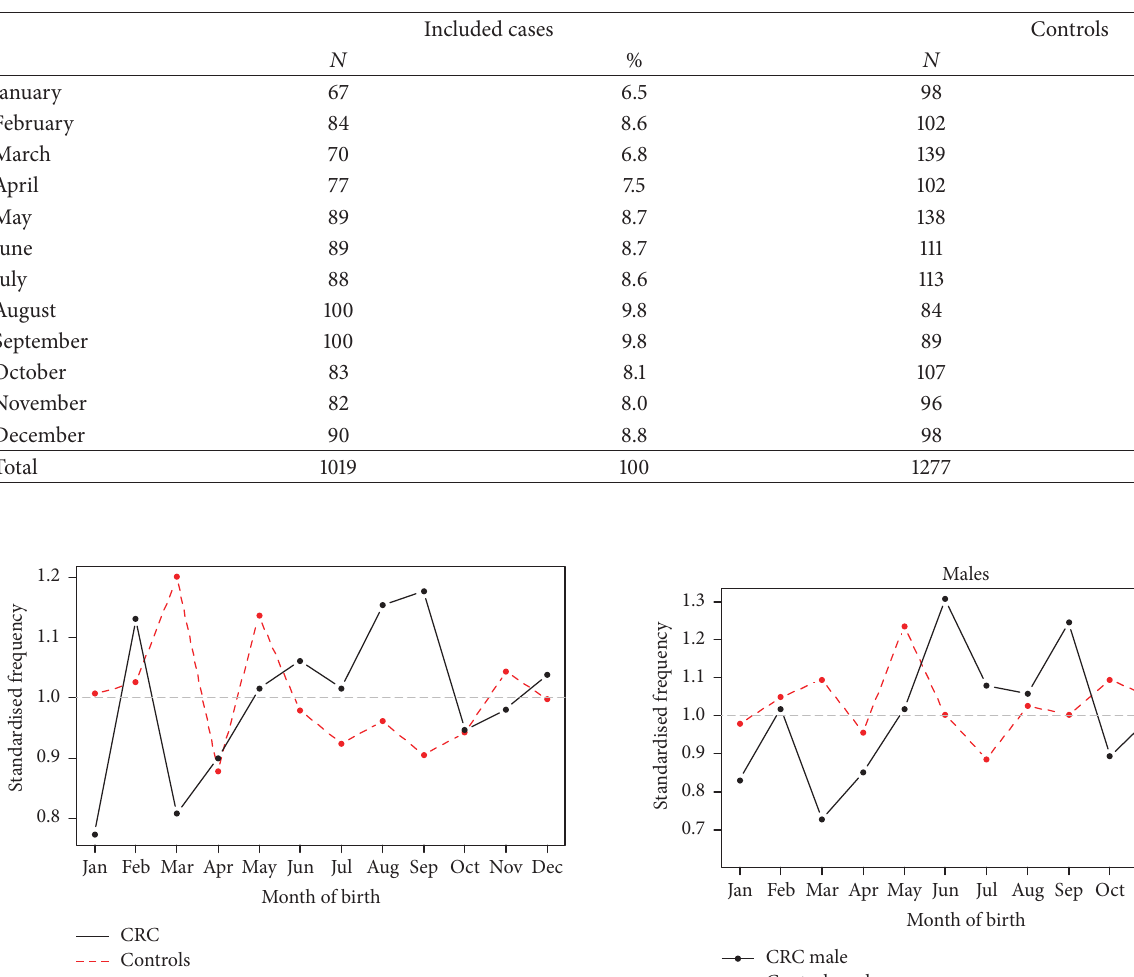
Table 2: Month of birth for case and control groups. No significant differences are seen between the groups ( p = 0.776).